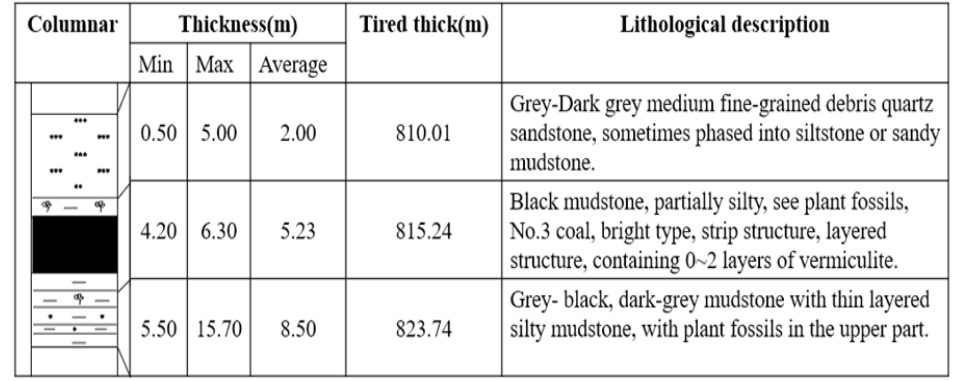
Figure 3. (a) Geometric and (b) meshing model.